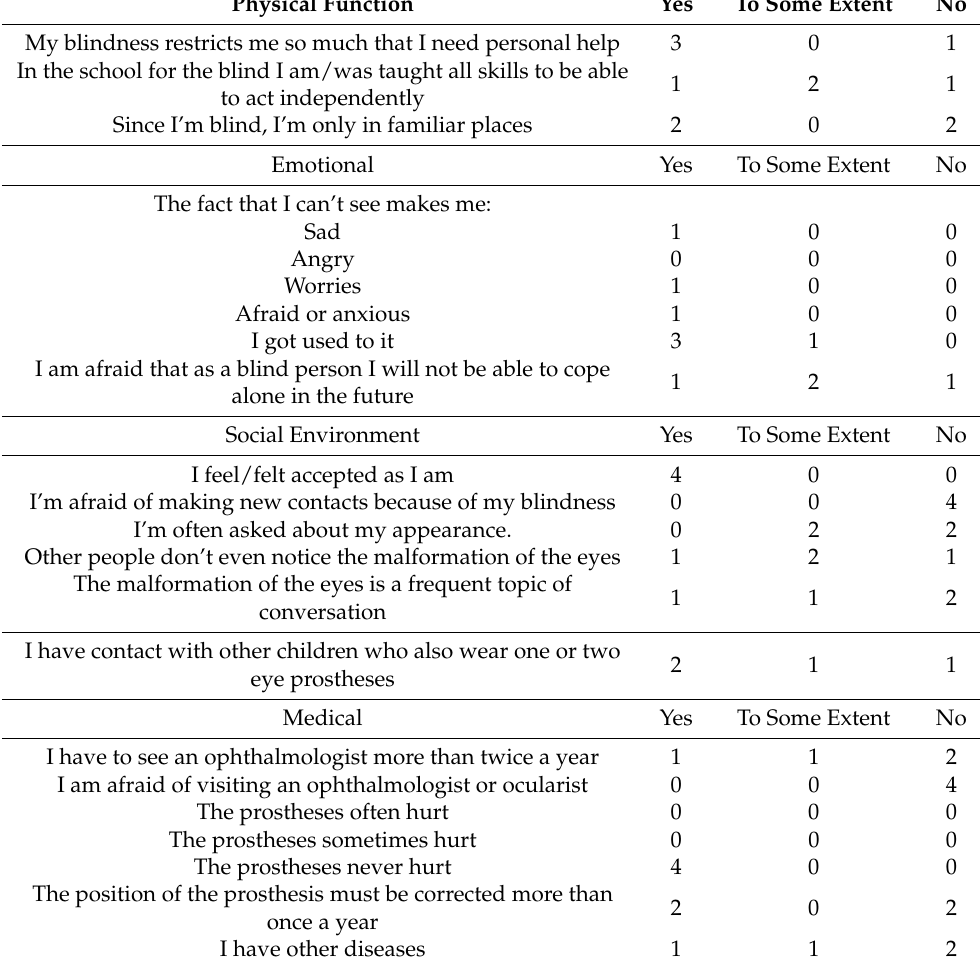
Table 3. Frequencies of responses of patients with bilateral clinical